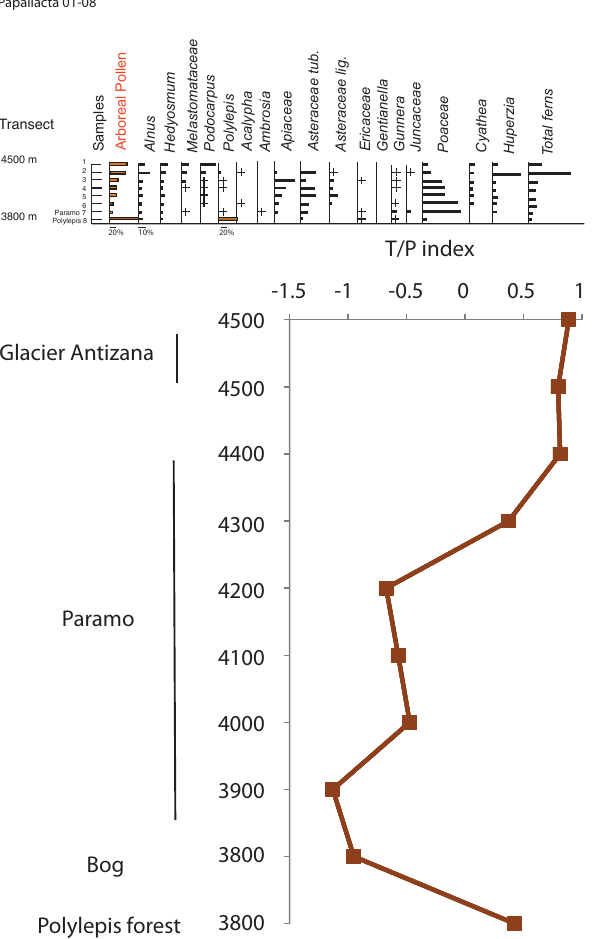
Fig. 4. (a) Pollen diagram showing the modern pollen rain along a transect between Antizana glacier (4500m) and Papallacta bog (3800m) for the main taxa. (b) T/P index of convective acitivity for surface samples along the altitudinal